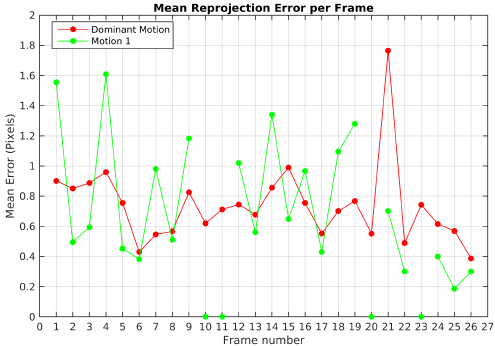
Figure 7. Mean reprojection error of detected motions for Scene 3 with baseline method.